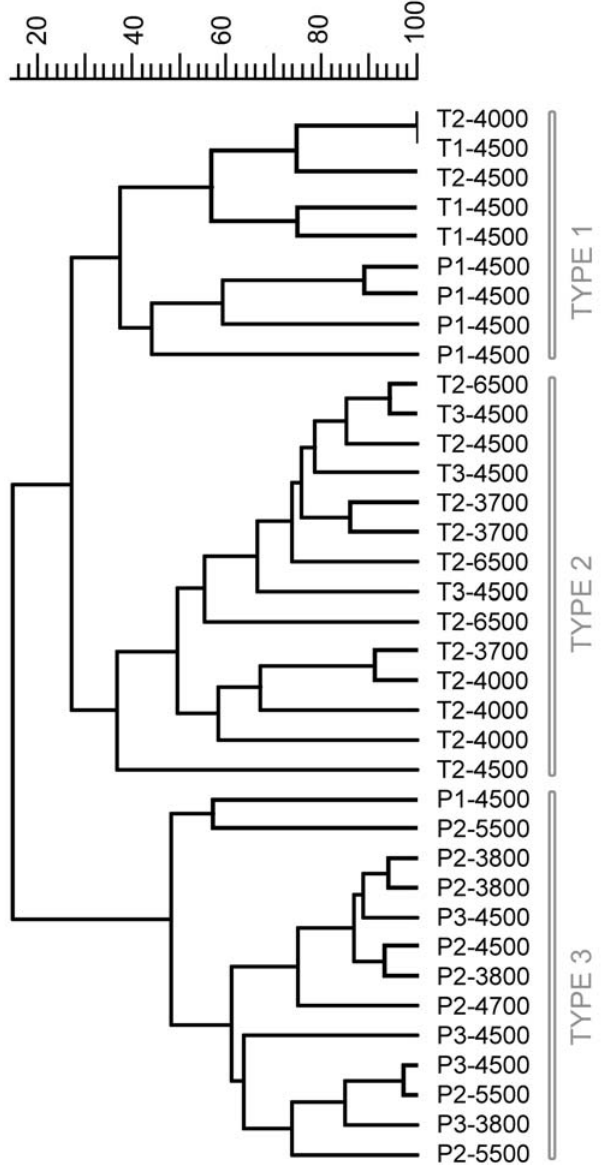
Figure 5. Dendrogram of the draining lymph node histopath- ological profiles. Each label indicates (in order): infecting species (P for Y. pestis , T for Y. pseudotuberculosis ), delay between mouse infection and lymph node collection (in days), amount of injected cfu. Top scale=% similarity doi:10.1371/journal.pone.0001688.g005 first two axes of the DLNs with advanced- Y. pestis and advanced- Y. pseudotuberculosis lesions. It can be seen on the figure that the Y. pestis and the Y. pseudotuberculosis groups are clearly separated from each other, thus confirming by another method that the two Yersinia species induce different alterations of the DLN. Figure 8 also displays the 42 criteria. Criteria located on the left- and right-hand side of the graph are those that characterize Y. pseudotuberculosis - and Y. pestis -induced lesions, respectively.